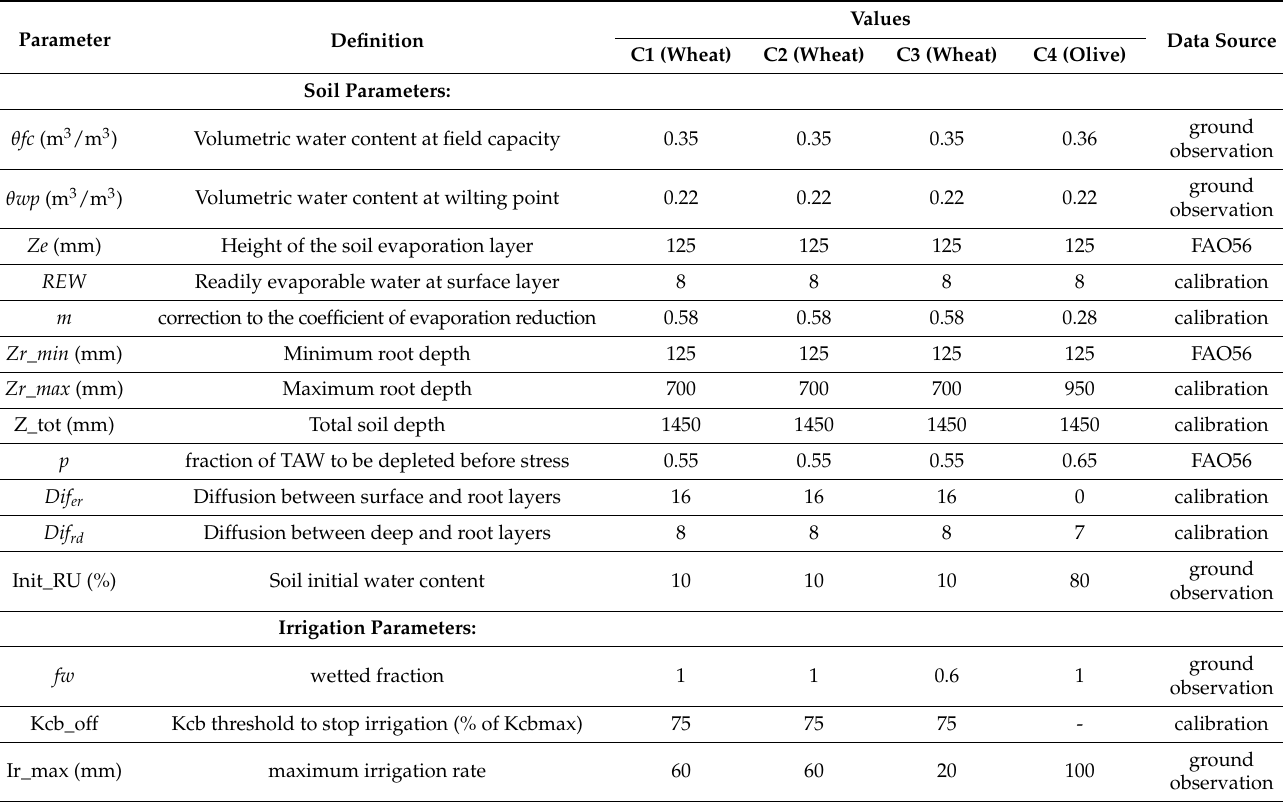
Table 2. Parameters obtained after calibration on observed crop evapotranspiration (ET) for wheat (three plots) and olive trees (one